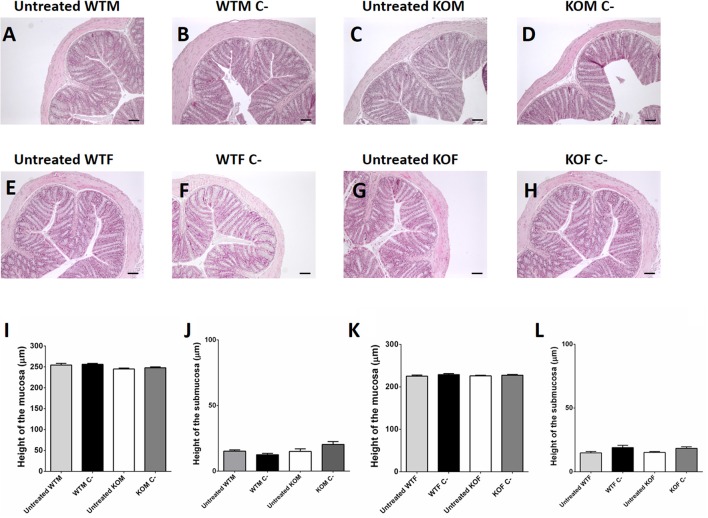
Microscopic evaluation of Ethanol-instillation action in the colon. Some preliminary experiments were performed to investigate whether control treatment with 50% ethanol in NaCl (C-) had any impact in tissue architecture when compared with colonic sections of animals which were not instilled (Untreated). Histological analysis of paraffin sections of males (A–D) and females (E–H) of both genotypes revealed that 50% ethanol in saline instillation did not cause any significant alteration in the morphology of the colon. Morphometric analysis revealed that control treatment with ethanol did not modify the height of the colonic wall neither of the mucosa (I,K) nor of the submucosa (J,L). Data are shown as mean ± SEM. (I,J) One way ANOVA + Tukey's MCT. Same groups as in Figure 1. Five animals per group. Scale bar = 50 μm.